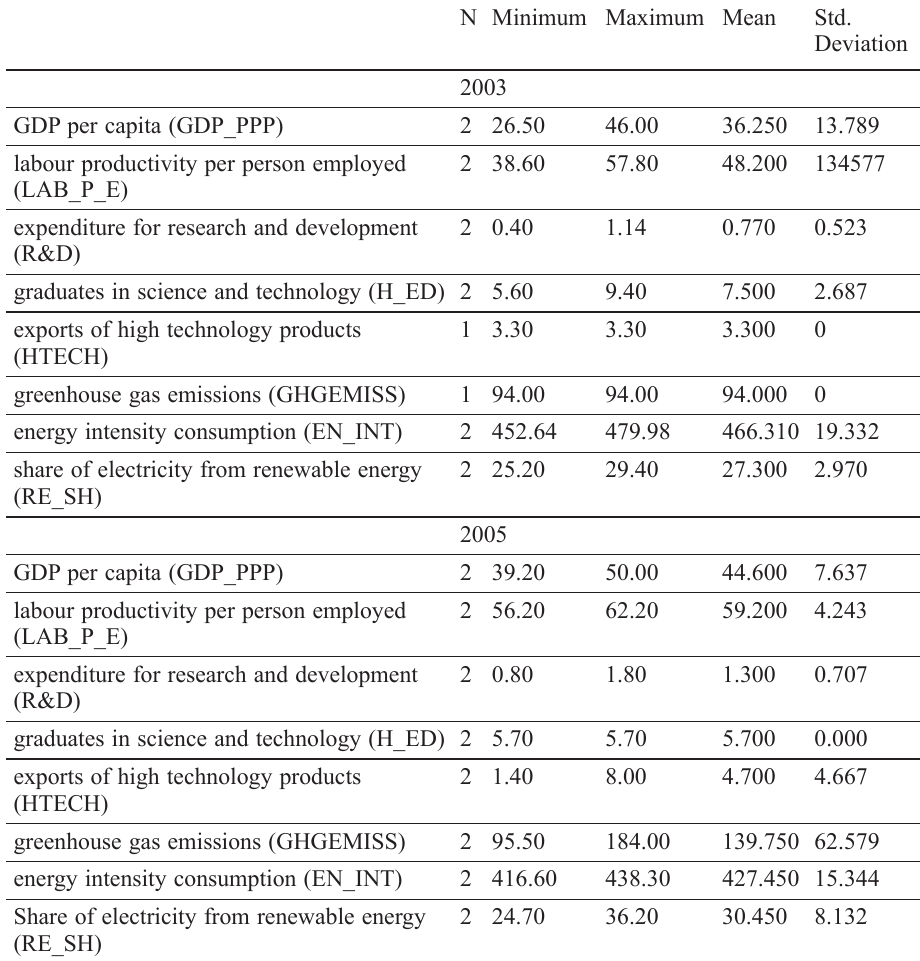
Table 6. Descriptive statistics of the analyzed structural indicators’ variables for the EU candidate countries (Croatia and Turkey) in 2003 and 2005 N Minimum Maximum Mean